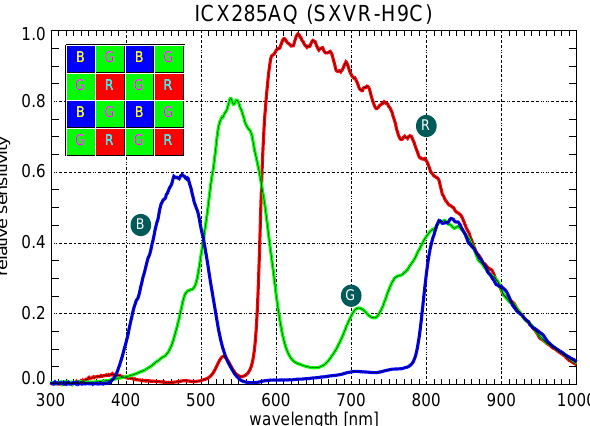
Figure 2. Spectral response for the three-channel (RGB) Sony ICX285HQ CCD with Bayer color mosaic inset.